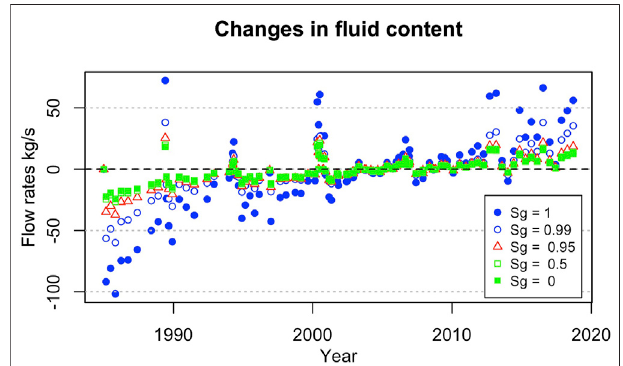
FIGURE8| Flowratesofatwo-phase fl uidmixturerequiredtocausethe observed deformation. Symbols of different shape and size refer to different gas fractions (Sg). Flow rates obtained with single-phase gas or liquid are also reported(solidsymbols)forcomparison.Valuesarecomputed basedon the observed displacement published by Del Gaudio et al. (2010) and De Martino et al. (2014). See text for further discussion.